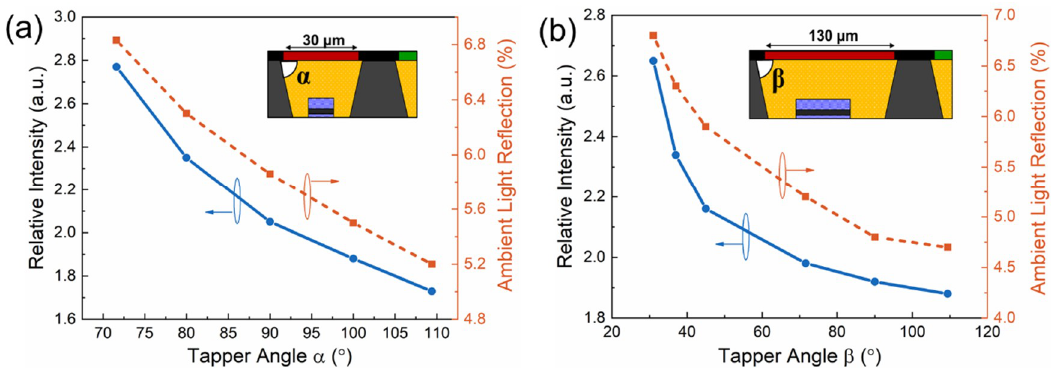
Figure 5. Cross‐sectional views of device B in the ( a ) x-z panel, and ( b ) y-z plane.